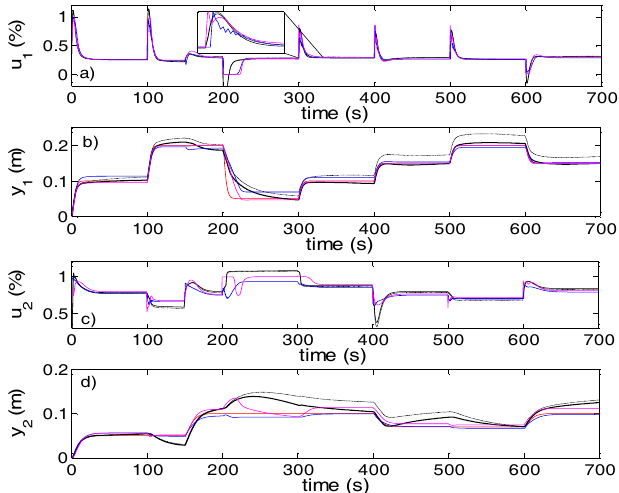
Figure 3. The initial VRFT controller (black dotted), the final adaptively learned controller (black solid), the BFQ controller (blue), the model-based BFQ controller (magenta) and the ORM outputs (red).